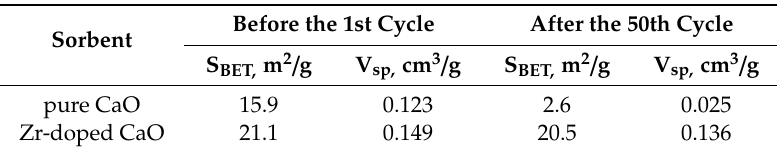
Table 1. The specific surface area and pore volume of the virgin sorbents and the same sorbents after carbonation – calcination cycling.